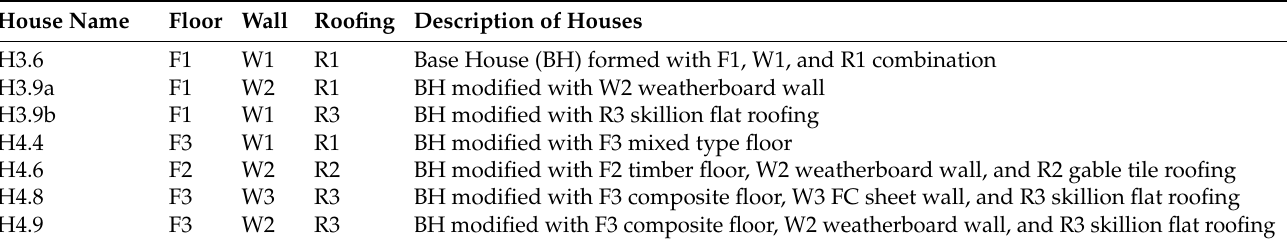
Table 7. Description of assemblages used to form different alternative